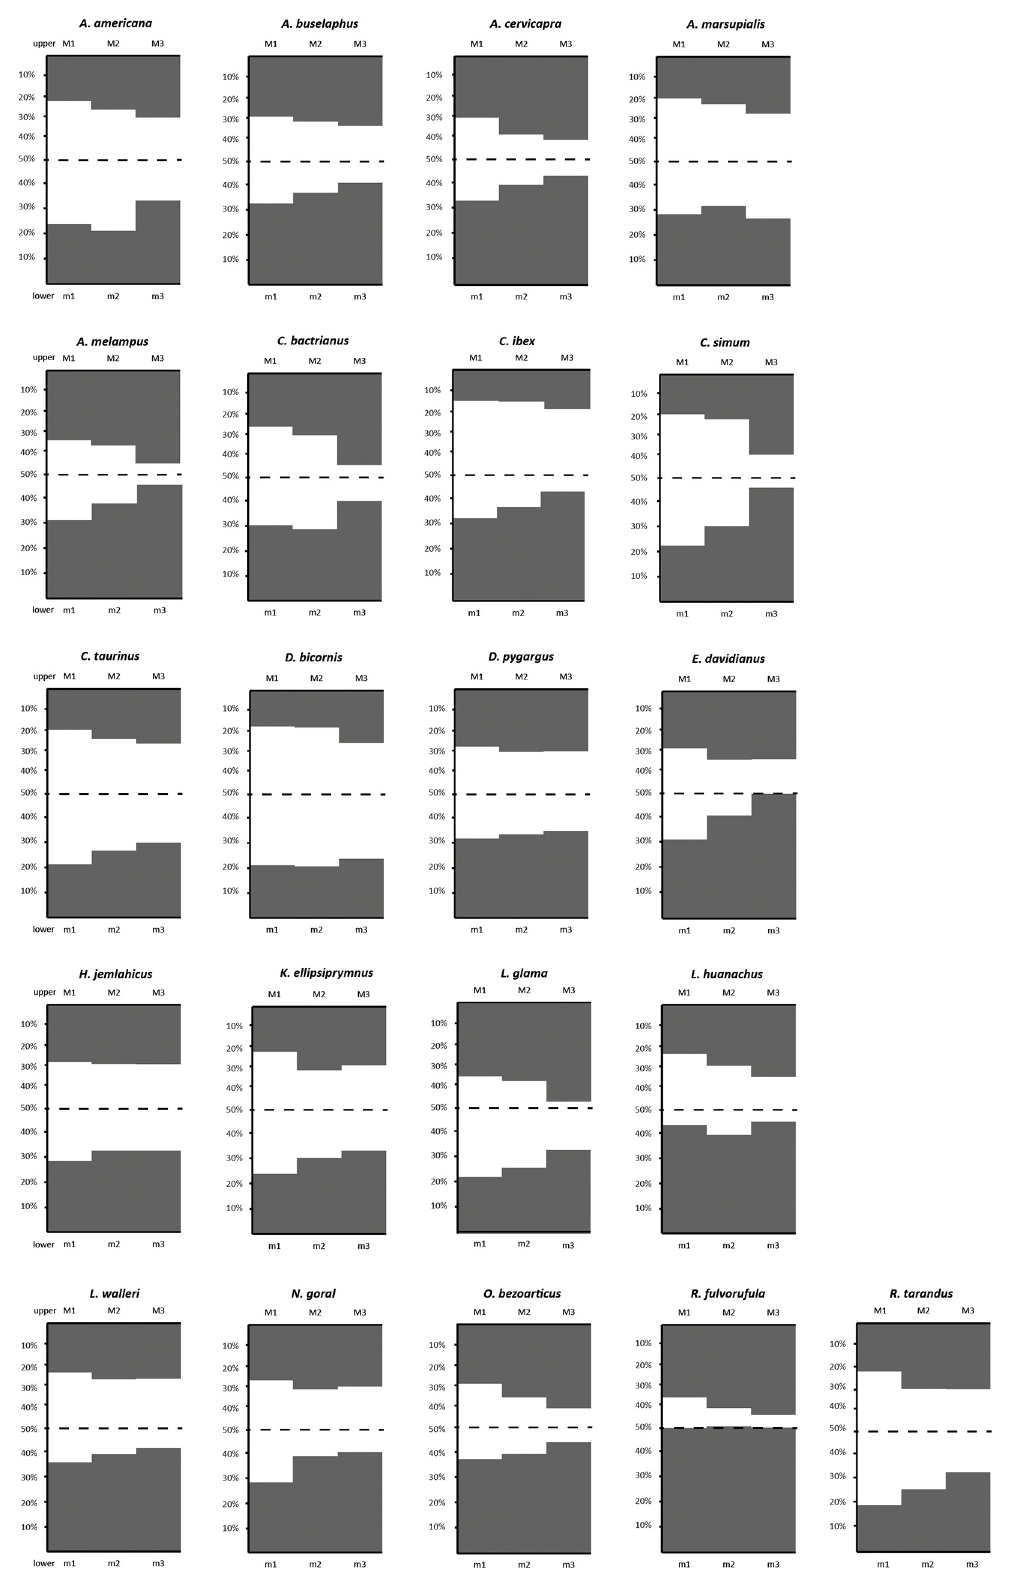
Fig 3. Histograms of relative enamel content for upper and lower molars of each species. doi:10.1371/journal.pone.0135716.g003 PLOS ONE | DOI:10.1371/journal.pone.0135716 August 27,